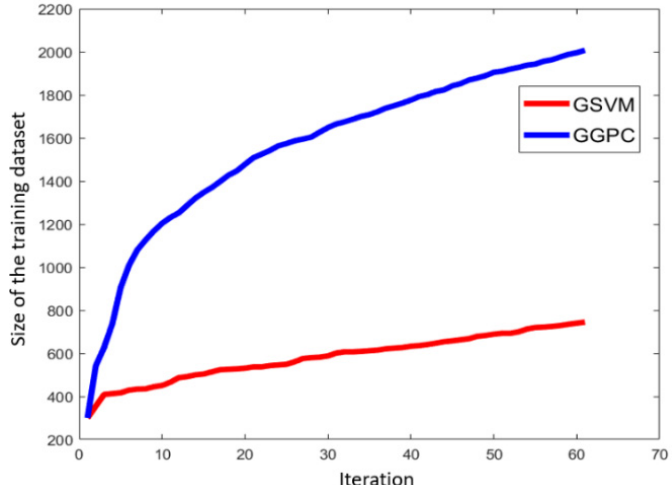
Figure 14. Size curves of the training datasets for GSVM and GGPC in experiments involving cut-in scenarios. The blue and red curves belong to GSVM and GGPC, respectively.